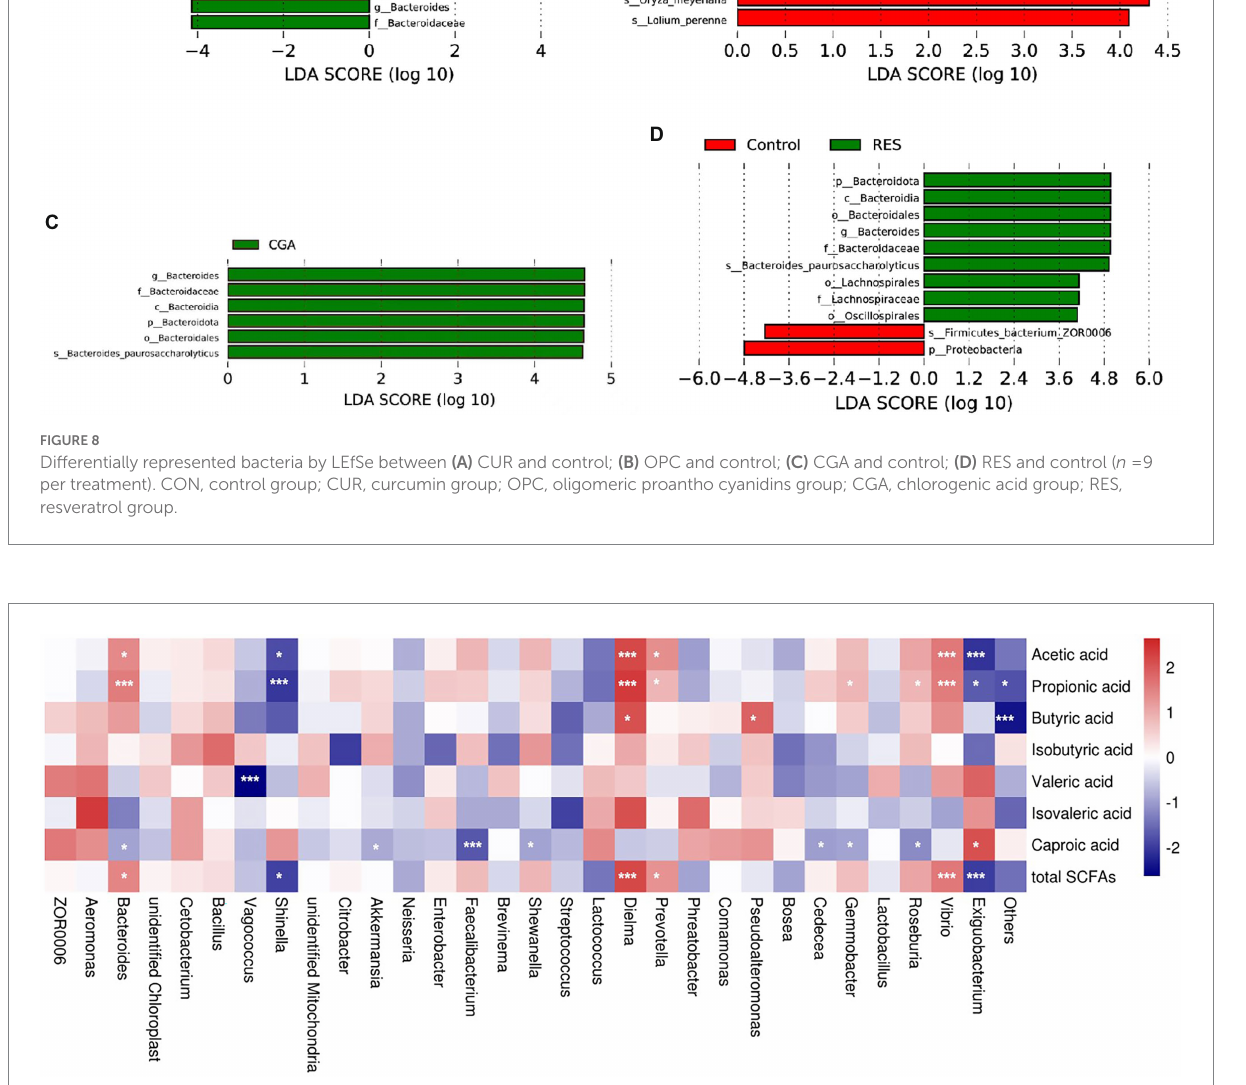
FIGURE 9 Correlation analysis between relative genus abundance and short chain fatty acids. Red denotes a positive correlation and blue denotes a negative correlation. Color intensity reflects the degree of correlation. Significant differences were labeled as * and *** for p < 0.05 and p < 0.001,